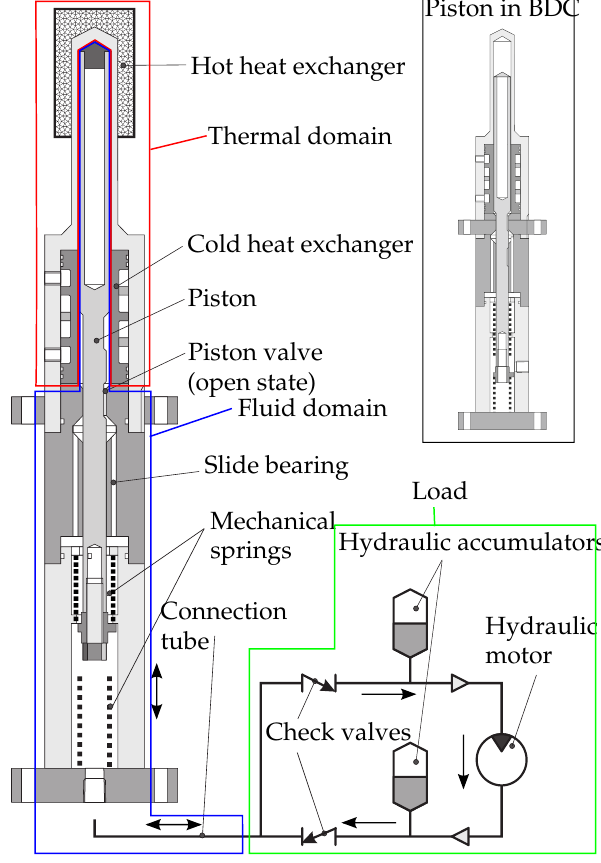
Figure 1. Schematic of the Up-THERM heat engine with hot heat-exchanger (HHX) and cold heat-exchanger (CHX), piston, piston valve, mechanical spring and hydraulic motor with piston at top dead centre (TDC) and bottom dead centre (BDC,